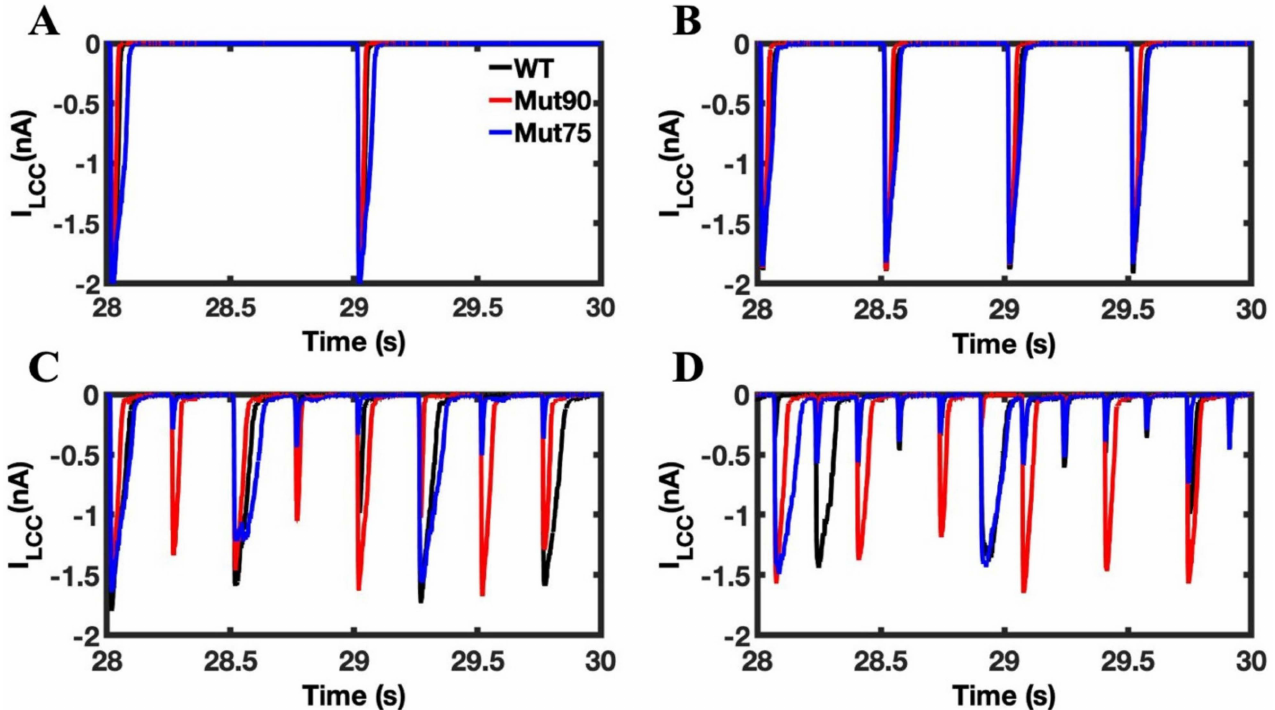
Figure 13. LCC calcium current in cardiac myocyte simulations under beta-adrenergic stimulation: ( A ) 1 Hz pacing, ( B ) 2 Hz pacing, ( C ) 4 Hz pacing, and ( D ) 6 Hz pacing. The wild-type cardiac myocytes (black) show consistent morphology with increased pacing. The mutant simulations CDI (75% of transition rate—blue and 90% of transition rate—red) of the cardiac myocyte show that the differences in the Ca 2+ current through the LCC are undetectable in the cardiac myocyte simulations, but the impact of reduced CDI increased the current during pacing in beta-adrenergic stimulation. Shown are representative simulations out of six repeated simulations with different random number seed values in each case. The different simulation traces for each condition overlap at steady-state